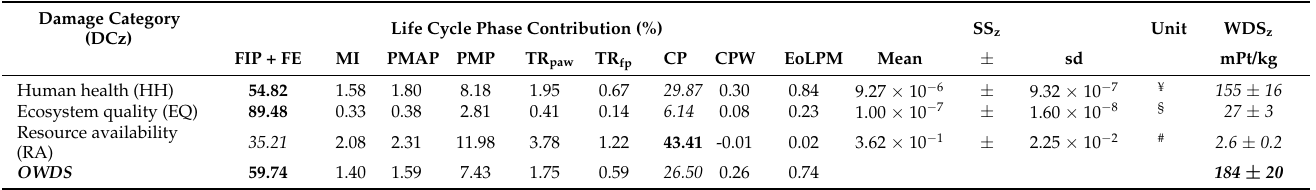
Figure 6. Radar diagram of the B2C environmental profiles of high-amylose fresh pasta either in the default conditions (dark blue broken line) or in the three mitigation options considered below (green dash-dotted line) as referred to that of the conventional common wheat flour counterpart (red dotted line). For the acronyms of the 18 impact categories refer to Table 7. Table 8. Endpoint characterization of the environmental profile of 1 kg of fresh pasta packed in 0.5-kg PE bags according to the ReCiPe 2016 standard method: percentage contribution of the different life cycle stages (symbols as in Table 6), single (SS z ) and weighted damage scores (WDS z ) of each damage category (DC z ), and overall weighted score